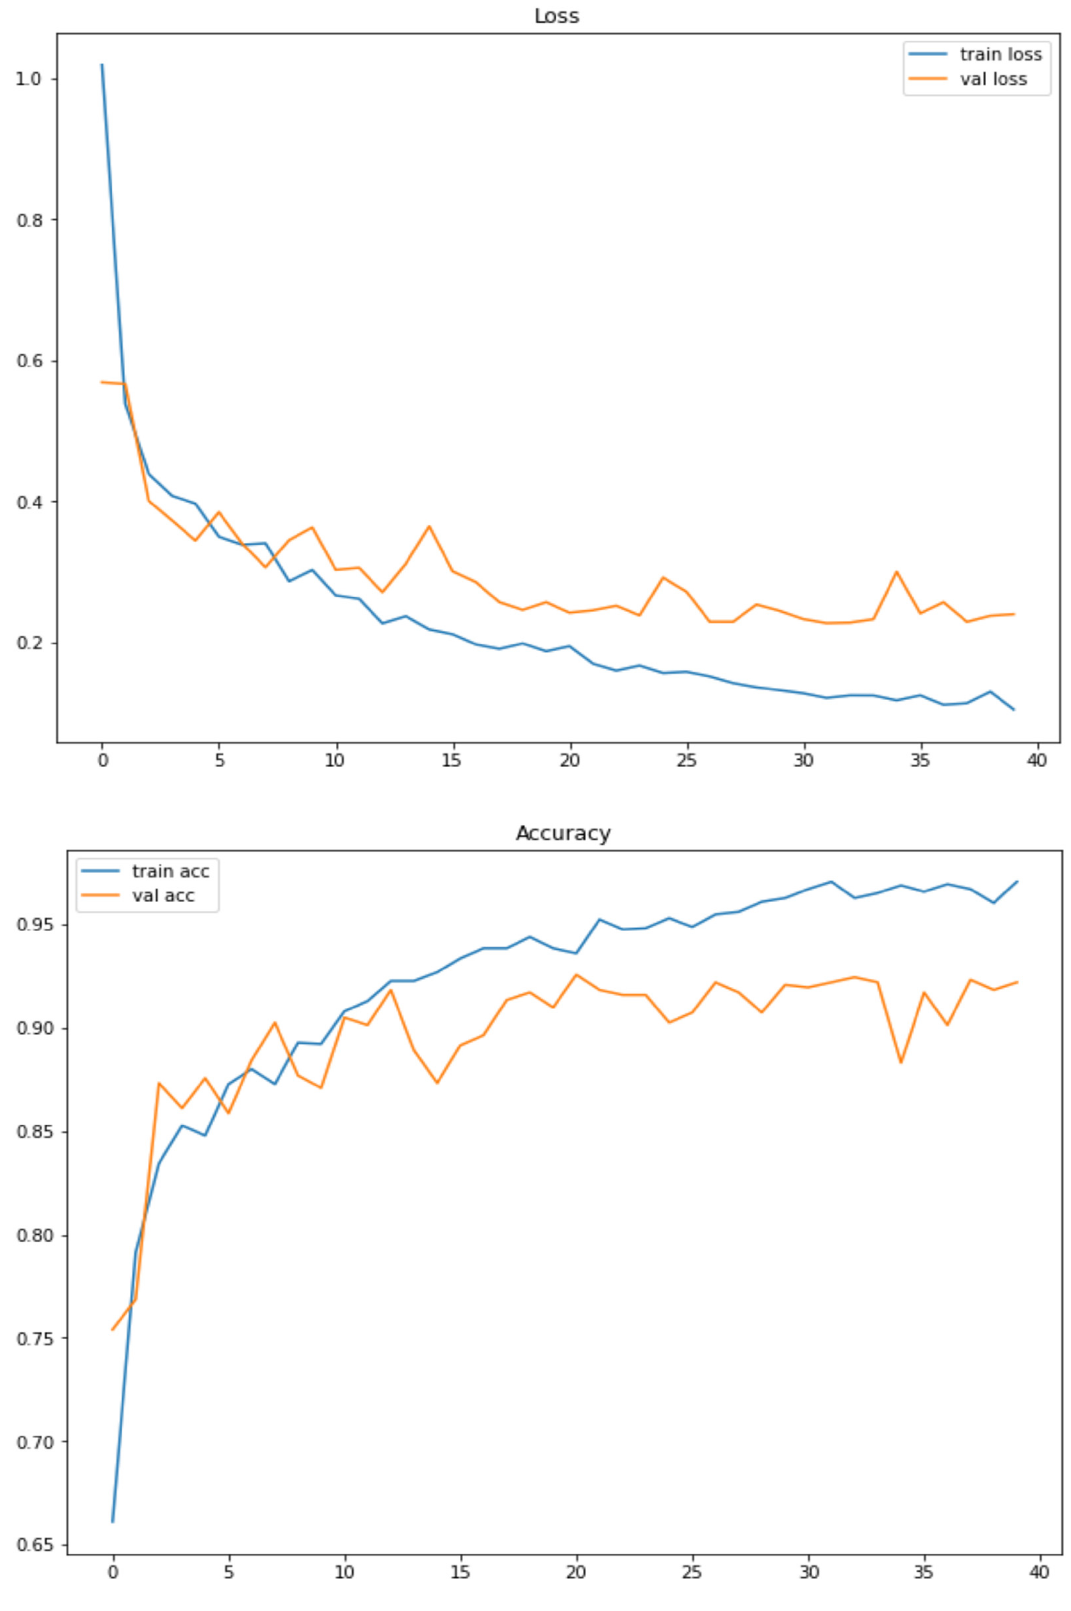
Figure 6. Training and validation plots of the VGG-19 model: loss graph ( top ) and accuracy graph ( bottom ).